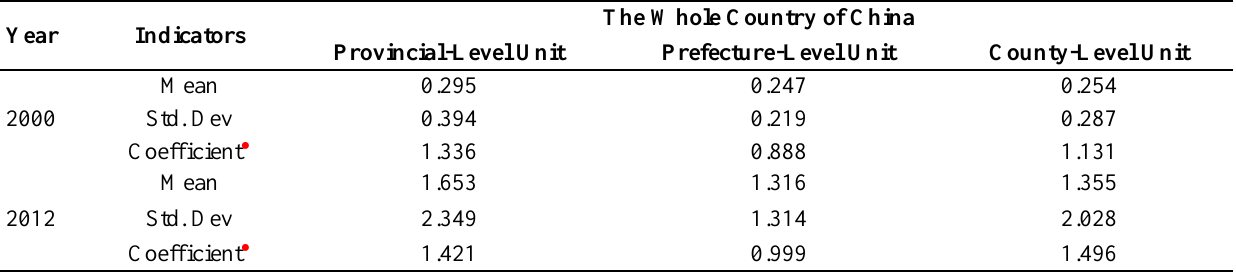
Table 2. Difference in the spatial field at three geographical scales in China.